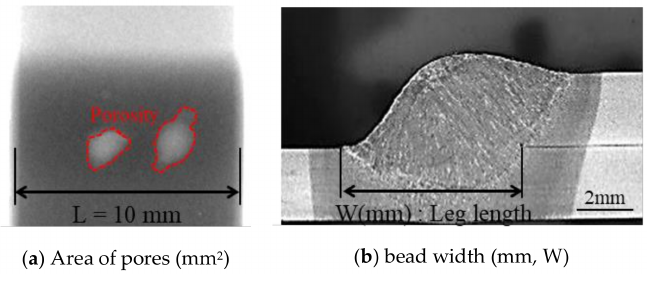
Figure 4. Measurement of the area of pores and bead